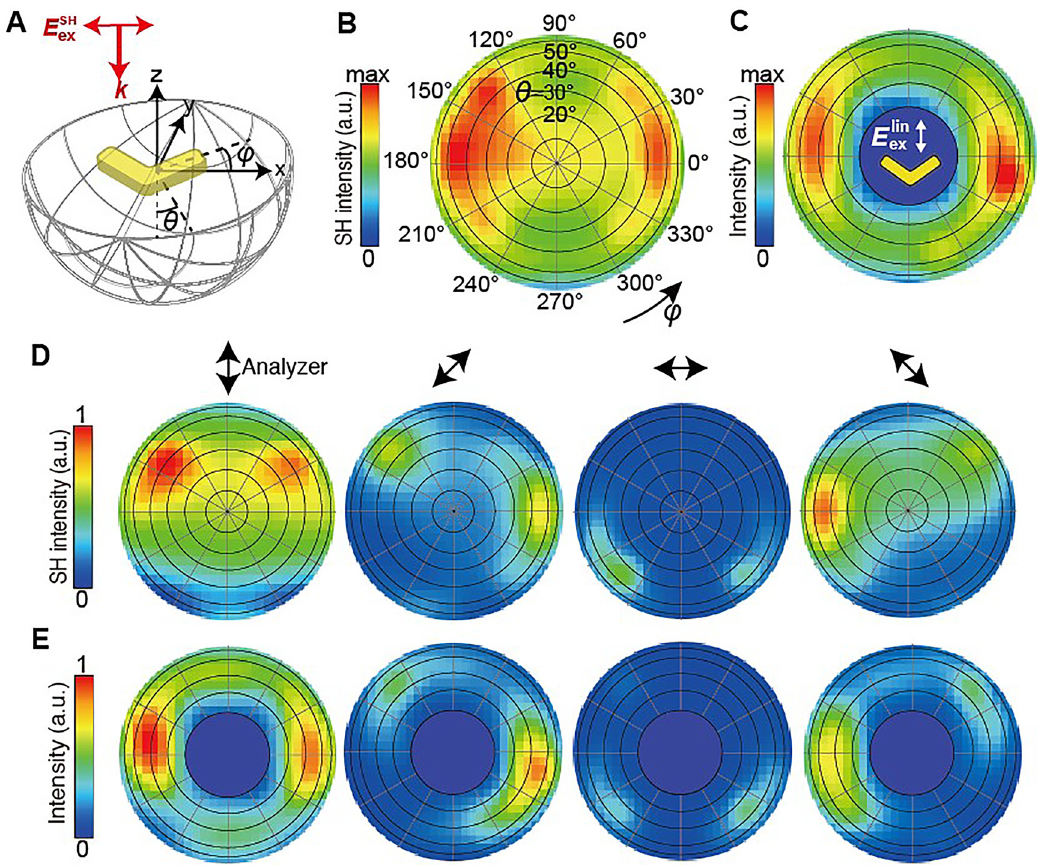
Figure 2: (A) Illustration of the coordinate system. The incident light is polarized along the x -direction to excite the D x mode for the SH generation. (B) Measured angular distributions of the SH-emission intensity from the V-shaped element on the substrate in Figure 1. The azimuthal angle φ and polar angle θ in (A) were obtained using back focal plane imaging (41). The SH wavelength matches the D y resonance peak at 750 nm. (C) Measured light scattering pattern in the linear response to y -polarized light illumination at 750 nm, which directly excites the D y mode.(DandE)PolarizationanalysisoftheSH-emissionintensityin(B)andthelinearscatteringintensityin(C),respectively,obtained through an analyzer. The results are in good agreement with each other. The color scale indicates the normalized scattered light